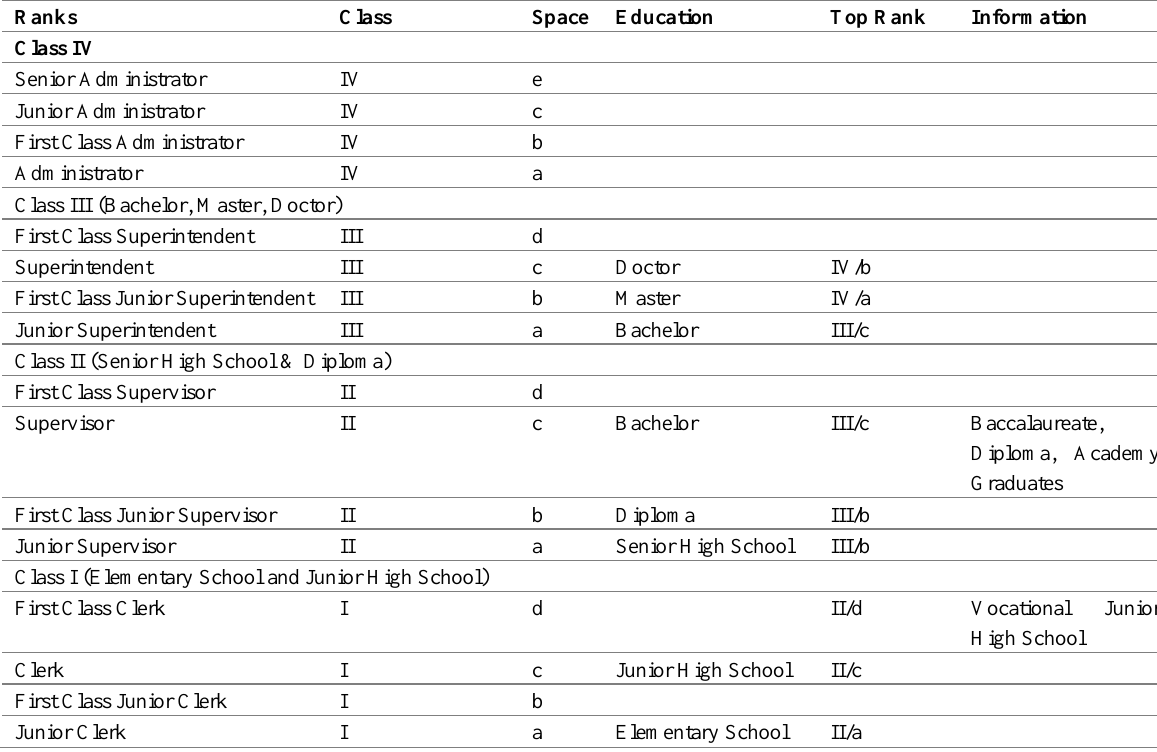
Table 1: Ranks of Civil